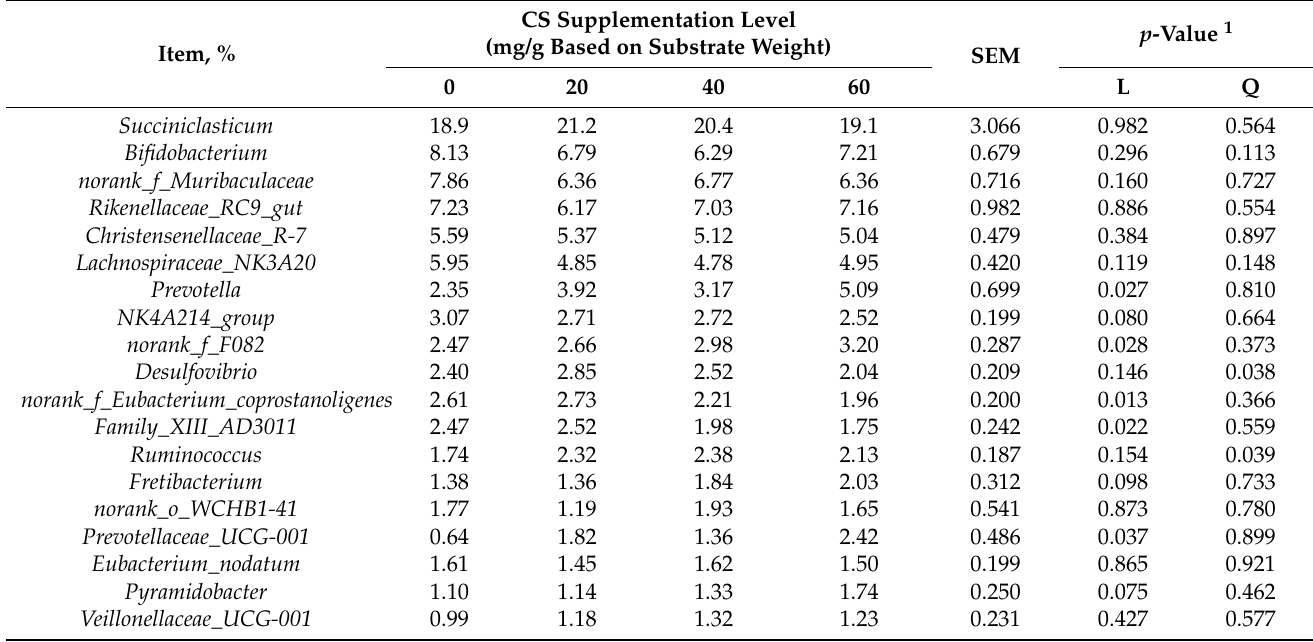
Table 6. Microbial community analysis at the genus level (relative abundance > 1%) of microbiomes with increasing CS supplementation level in HF group.